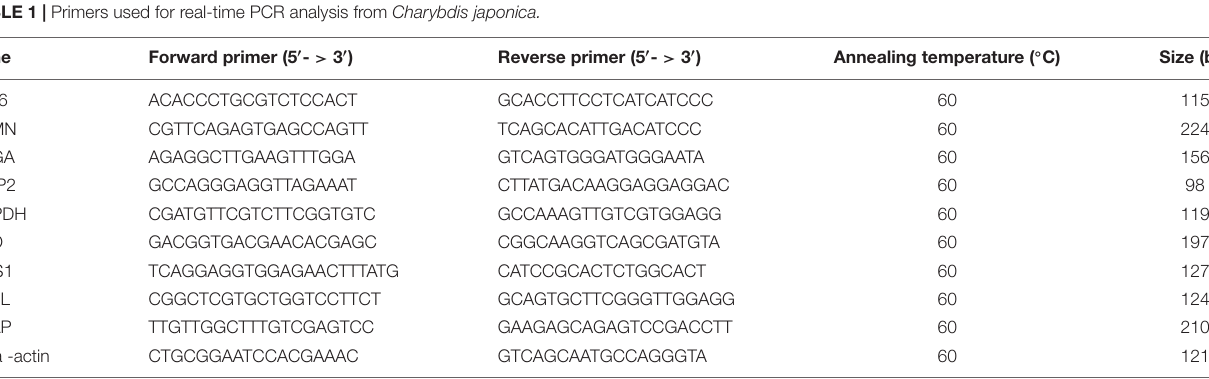
TABLE 1 | Primers used for real-time PCR analysis from Charybdis